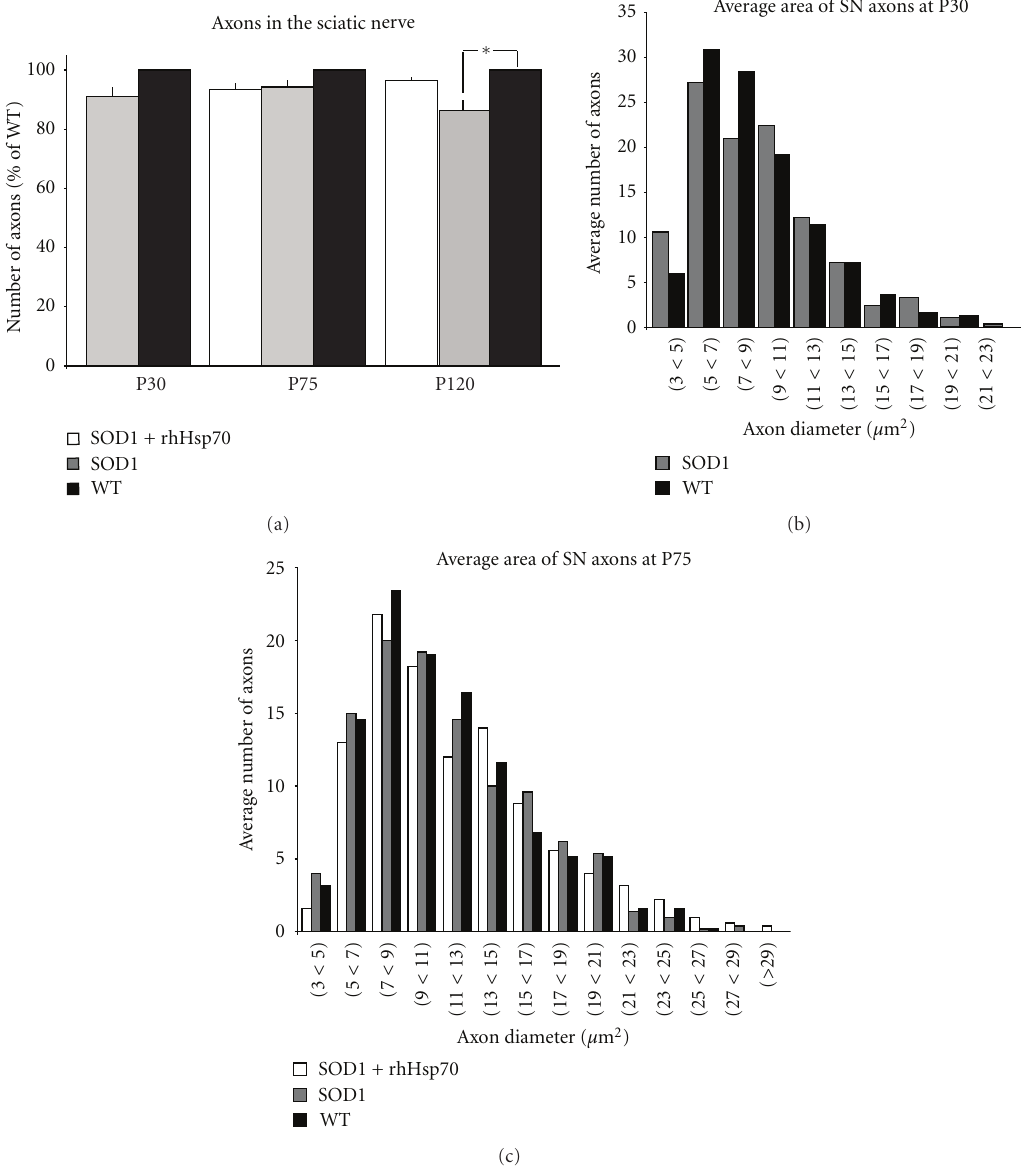
Figure 3: There is no change in number or size of axons in sciatic nerve with rhHsp70 treatment. (a) There was no di ff erence in the overall number of myelinated axons in the sciatic nerve at P30 or P75. Data are represented as percent of WT ± SEM at each time point; n = 5 for each group. Statistical significance was determined as previously described. (b) Size profiles of the axon area done at P30 revealed there was no di ff erence in the number of larger axons in SOD1 mice. Axon area and statistical significance were determined as previously described. (c) Data are representative histograms of the average area of myelinated axons in the sciatic nerve of each group at P75. There was not a significant di ff erence in average area number of axons between the groups at this age. Axon area and statistical significance were determined as previously